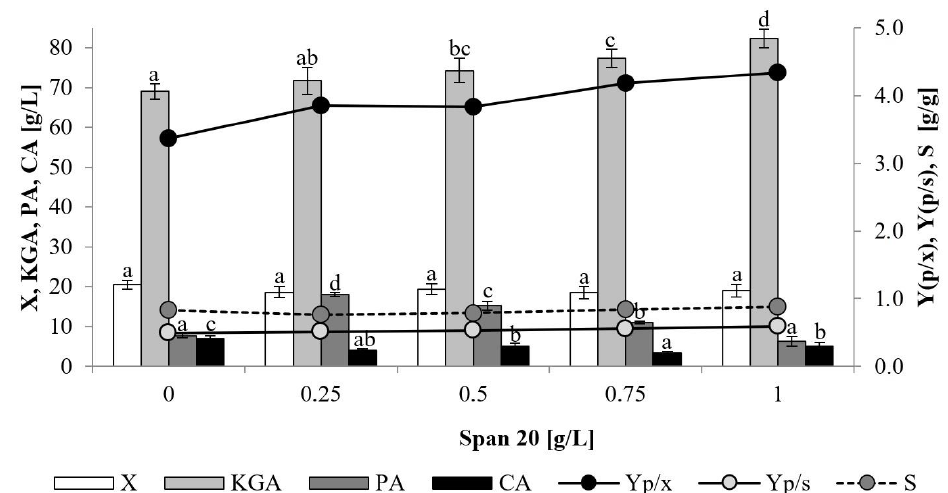
Figure 5. Impact of Span 20 on yeast growth and acids formation during KGA biosynthesis performed by Y. lipolytica CBS 146773 in mixed glycerol/oil-based media. Culture conditions: 20% Ca(OH) 2 , pH 3.5, 800 rpm, 3 µ g/L of thiamine. Abbreviations: X—biomass; KGA— α -ketoglutaric acid; PA— pyruvic acid; CA—citric acid; Y—yield of KGA with respect to biomass formed (p/x) and utilized substrates (p/s); S—selectivity of KGA relative to sum of acids formed (KGA/(KGA + PA + CA)). Mean values for a specific product concentration marked with different letters (a, b, c, . . . ) differ significantly at p ≤ 0.05. Error bars indicate standard deviations.